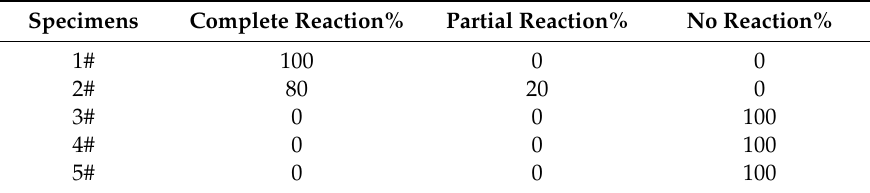
Table 3. Reaction rates of five types of specimens in quasi-static compression. Specimens Complete Reaction% Partial Reaction%